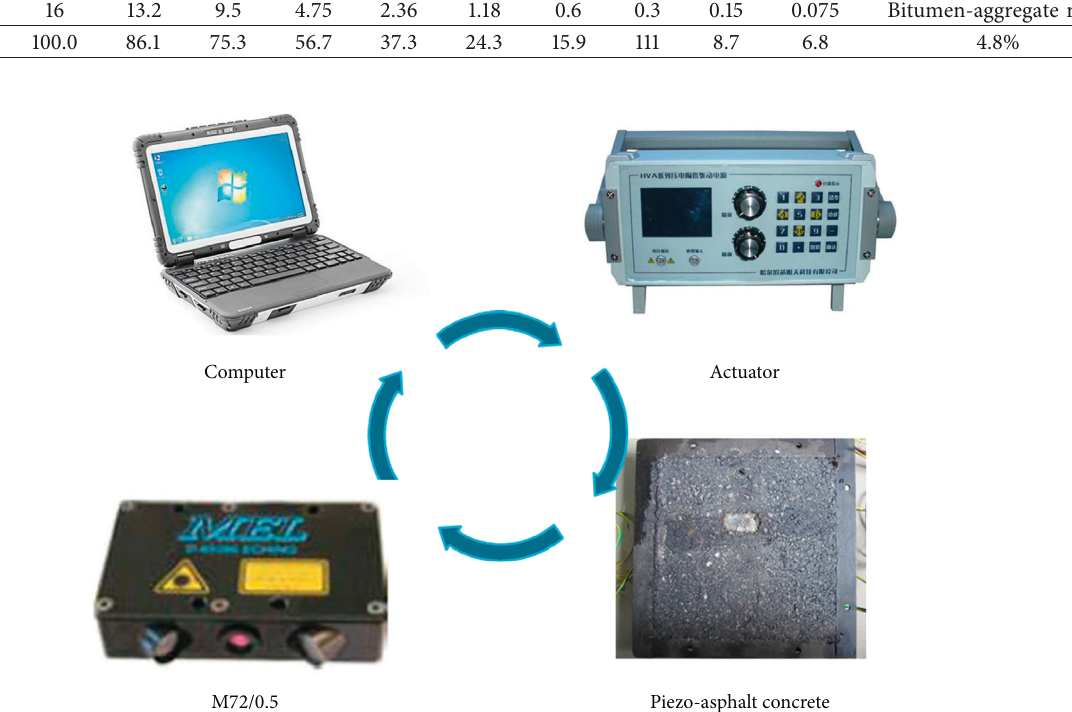
Figure 2: Diagram of the test